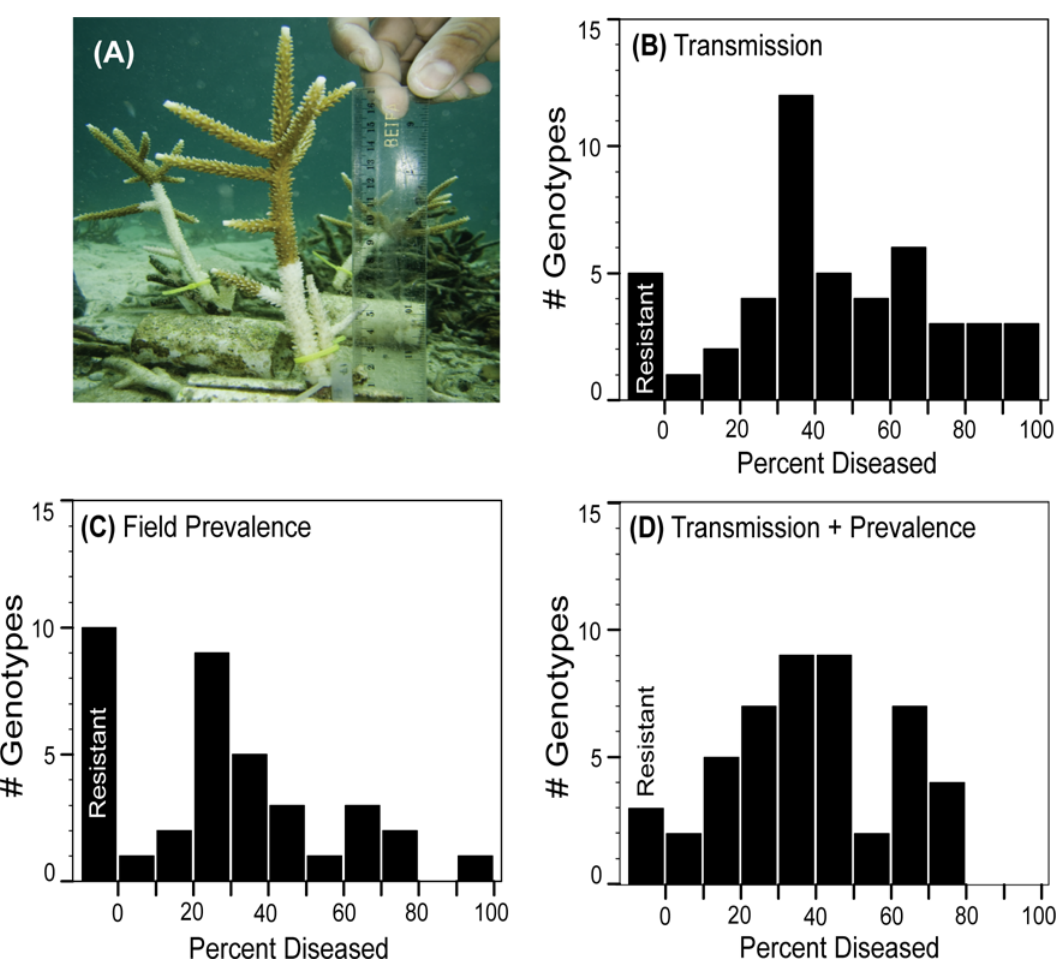
Figure 1. Resistance to White Band Disease (WBD) in the staghorn coral Acroporacervicornis . (A) WBD transmission to a coral fragment occurs rapidly as illustrated by the progress of the advancing white band of disease after three days of direct contact (grafting) with an infected coral fragment. (B) In situ transmission experiments identified five staghorn coral genotypes that did not contract WBD. (C) Field surveys of WBD prevalence identified ten genotypes that were not observed in the field with WBD. (D) Integrated field surveys and experimental transmission results show that three staghorn coral genotypes were resistant to WBD infection.